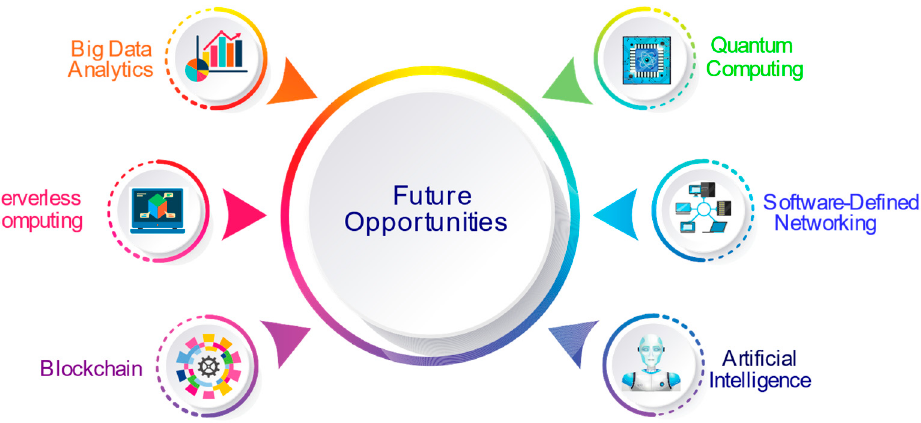
Figure 14. Future opportunities—fog computing and other evolving computing paradigms.